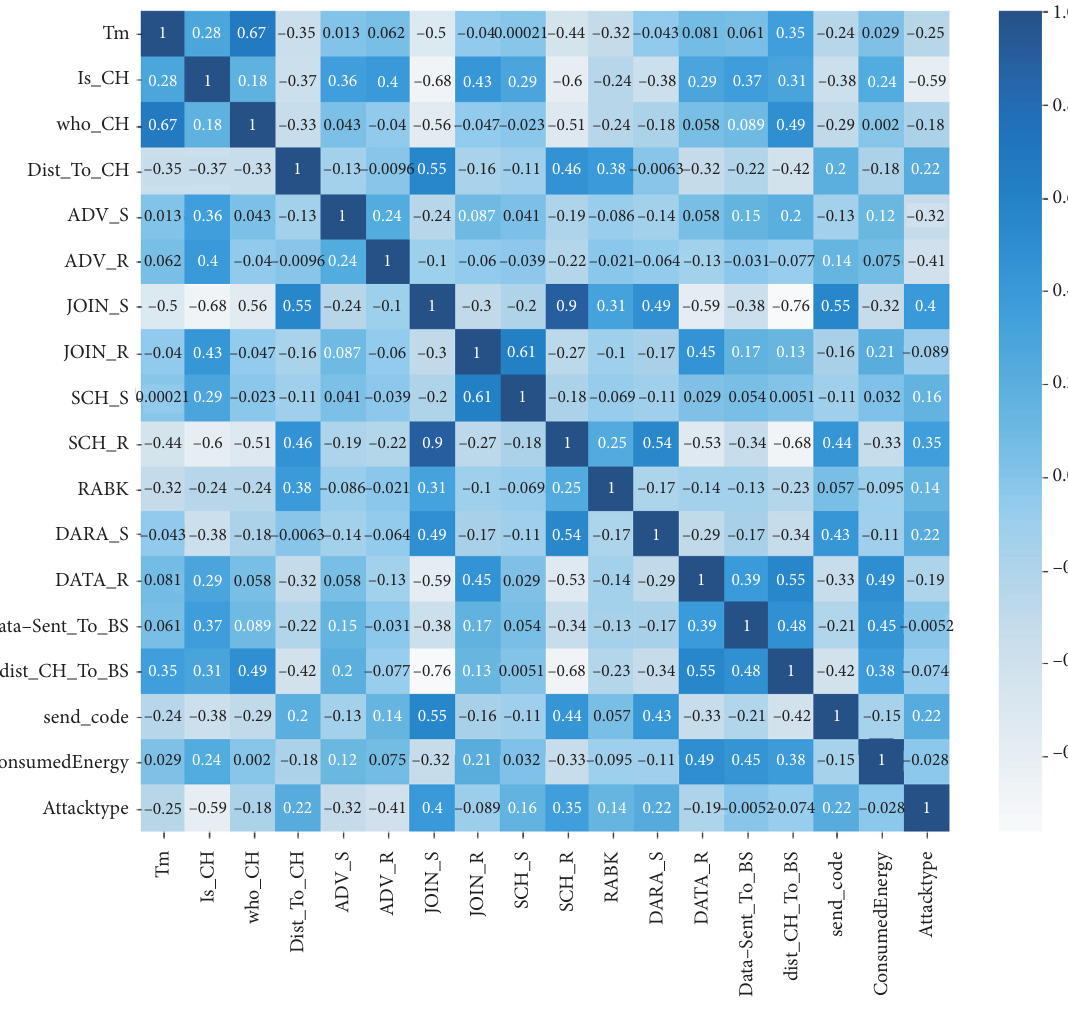
Figure 2: Correlation matrix between features for WSN dataset. Table 7: Feature selection of WSN dataset using p